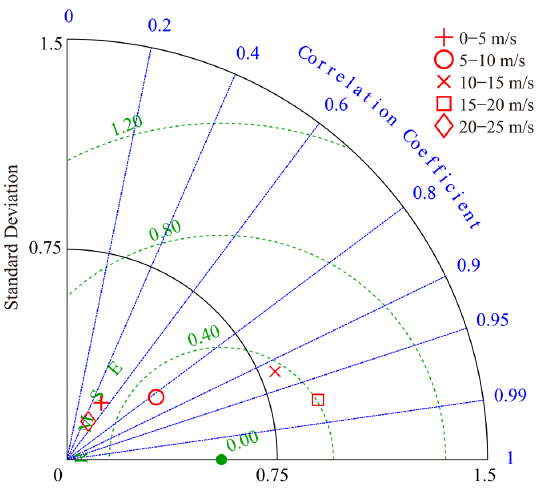
Figure 9. Validation of SAR-derived SWH against simulation results of the WW3 model in terms of wind speeds between 0 and 25 m/s.